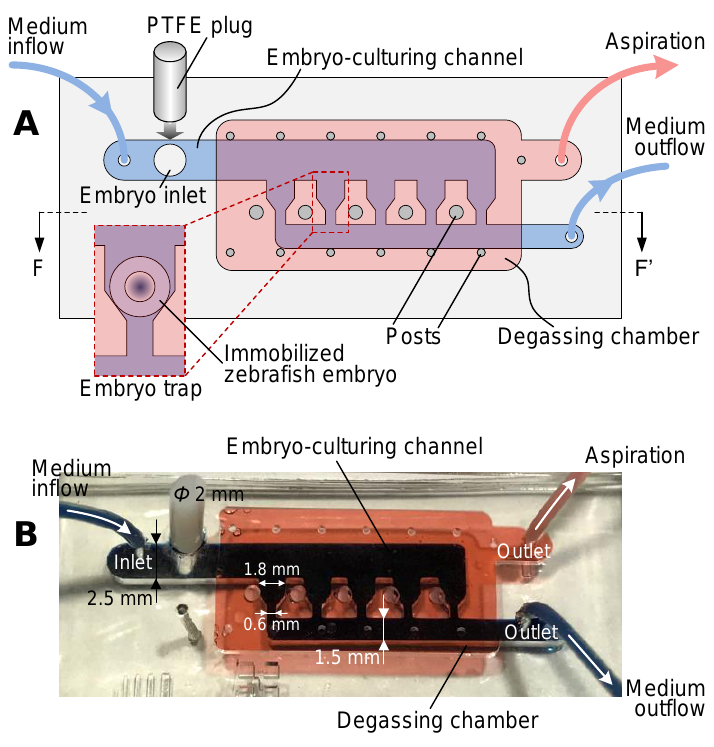
Figure 1. Overview of the microfluidic device for zebrafish embryo immobilization, culturing and monitoring. ( A ) Schematic of the microfluidic device with peripheral interfaces for embryo loading and trapping, culturing-medium perfusion, and degassing. ( B ) Device photo illustrating the embryo-culturing channel (dark blue), the degassing chamber (red), and the polytetrafluoroethylene (PTFE) plug (white) inserted in the embryo inlet.